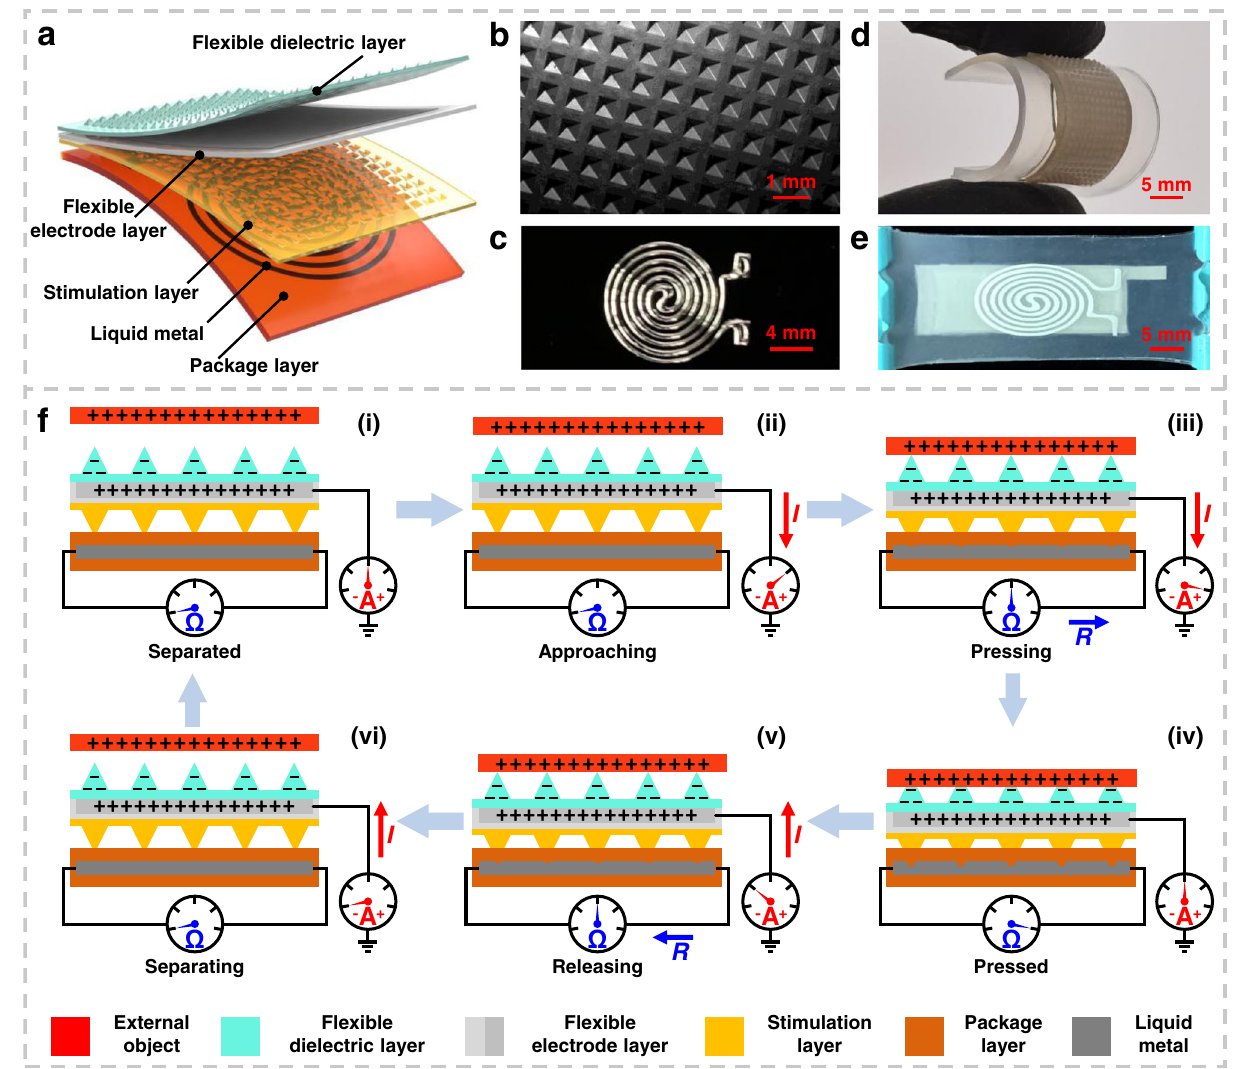
Fig. 2 | Design and sensing mechanism of the proposed tactile/touchless fl ex- ible bimodal smart skin (FBSS). a Soft sensor design with different functional layers stacked together. These layers include a fl exible dielectric layer (cyan), a fl exible electrode layer (gray), a stimulation layer (pale yellow), the liquid metal material (black), and a package layer (orange). b Electron microscope image of the micro-pyramid structuresonthetop sideof the fl exibledielectriclayer. c Anoptical microscopeimageoftheliquidmetalmaterialprintedonthesiliconemateriallayer. d A bending photograph of the FBSS prototype demonstrates its fl exibility. e A stretching photograph (maximum stretching rate is 58.4%) of the prototype demonstratesitsstretchingability. f Thetactile/touchlesssensingmechanismofthe prototype: (i) The equal density of negative and positive charges was generated on the fl exible dielectric layer (gray) and external object (red) due to the different